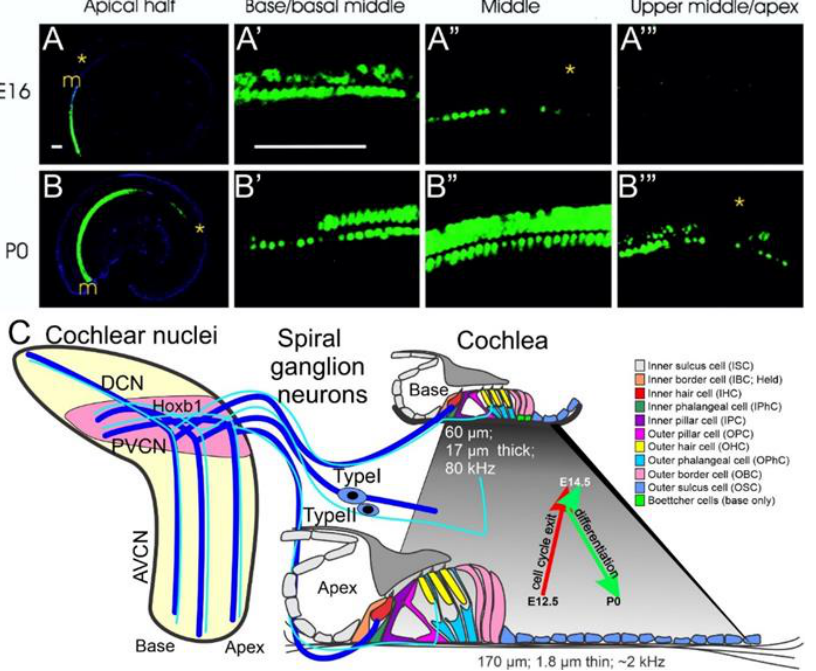
Figure 1. A composite set of development of the auditory system is revealed—Base-to-apex progression of α9-AChr expression in differentiating hair cells along the cochlea ( A , B ). The two different types of spiral ganglion neurons connect the cochlear hair cells with the cochlear nuclei (anteroventral (AVCN), posteroventral (PVCN), dorsal (DCN)), maintaining basal to apical tonotopic representation ( C ). The PVCN, located in rhombomere 4, expresses Hoxb1. An apex-to-base proliferation (E12.5–14.5) for cochlear hair cells is followed by a base-to-apex differentiation initiated by Atoh1 (E13.5–P0). The organ of Corti contains two different types of hair cells, inner and outer hair cells (IHC, OHC) arranged from high-frequency detection at the base (thick basilar membrane) to low-frequency detection at the apex (thinner basilar membrane). Approximately 15 type I fibers converge on a single IHC, whereas a single type II fiber expands along several OHCs. Central projections of type I and type II fibers are mostly parallel in the AVCN, maintaining a topographic map, though a slightly different pattern of organization exists in the PVCN. Modified after